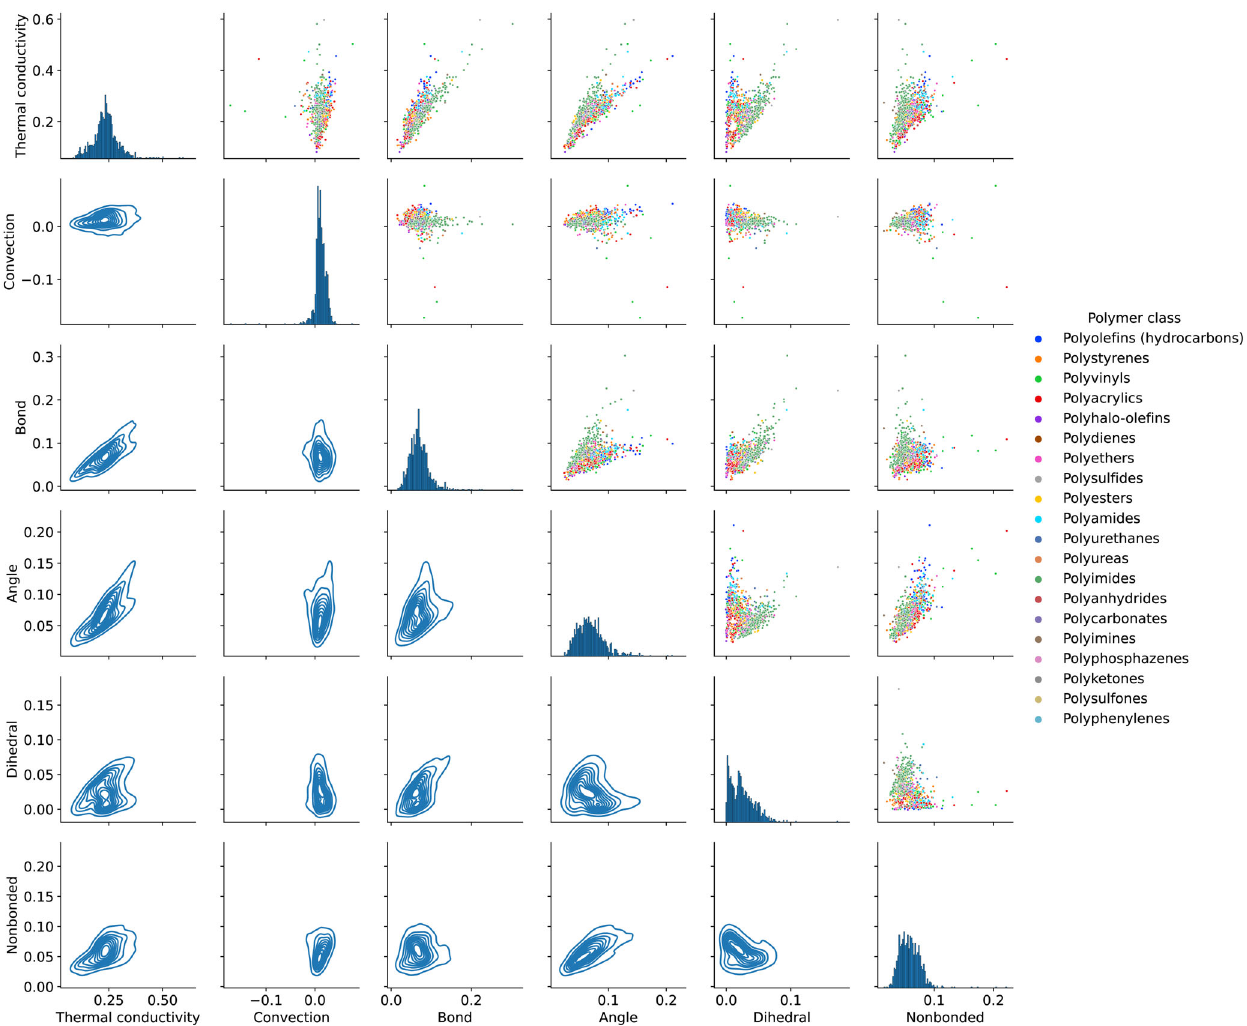
Fig. 7 Distribution of the thermal conductivity (W ∙ m − 1 ∙ K − 1 ) and categorization in terms of its contributions from convection, bond, angle, dihedral, and nonbonded terms. Diagonal panels represent the histograms of individual quantities. In the upper off-diagonal panels, the scatter plots of the six quantities are displayed. The lower off-diagonal panels represent their kernel density estimation, which is displayed with